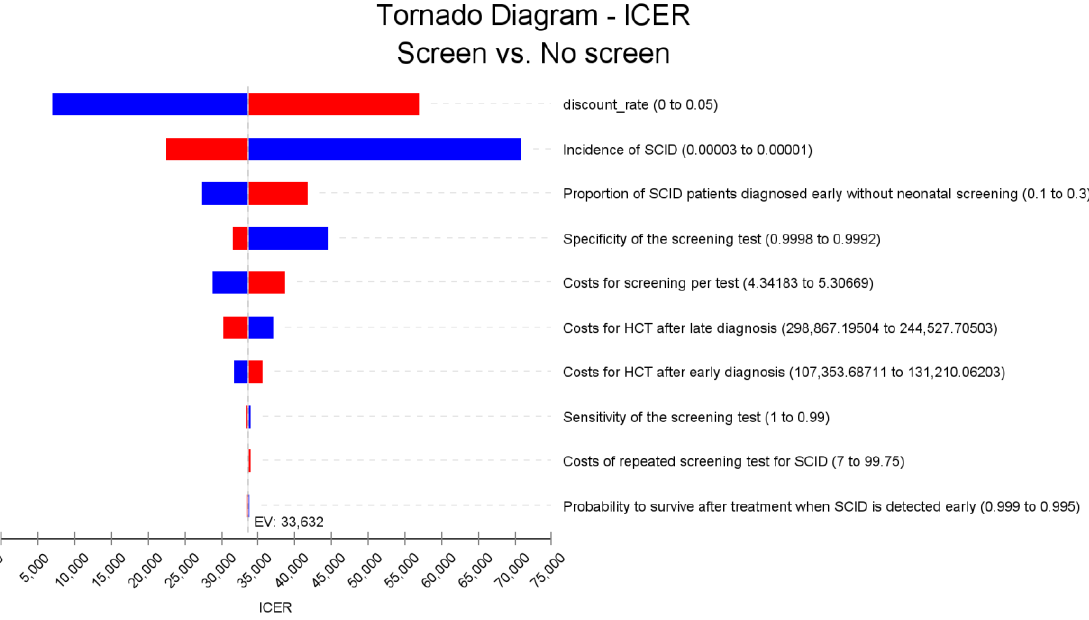
Figure 5. One-way sensitivity analysis for SCID NBS cost-effectiveness analysis, government per- spective. Note: Red bars indicate an increase in the parameter value from the base case value (Expected Value, EV line) and the blue bars show otherwise.